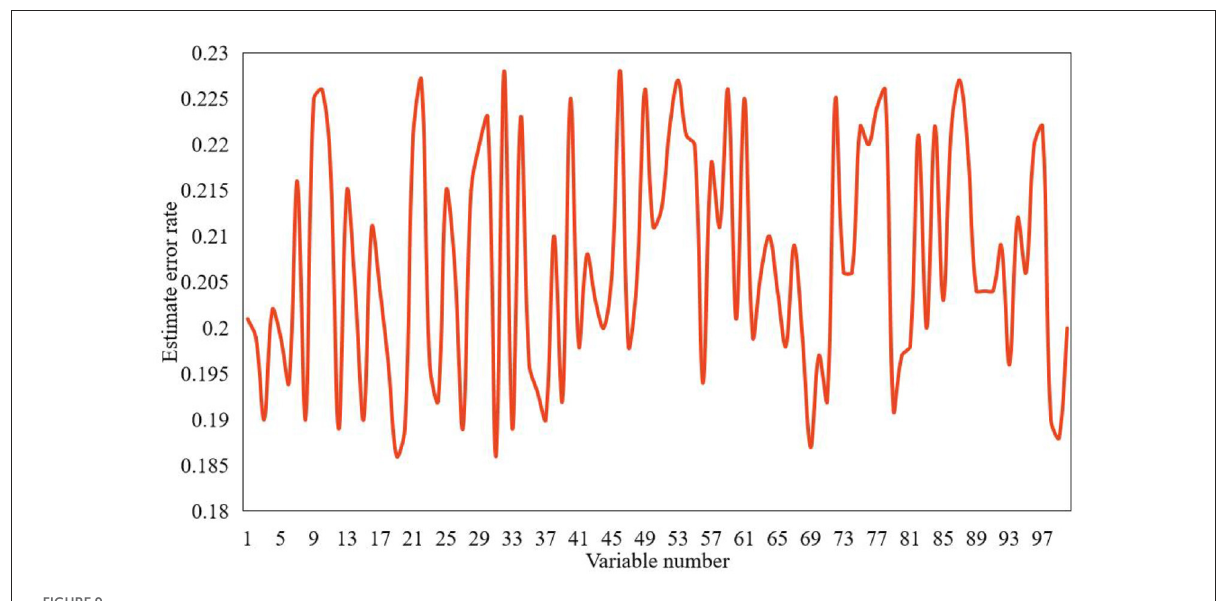
FIGURE9 Error analysis of psychological status